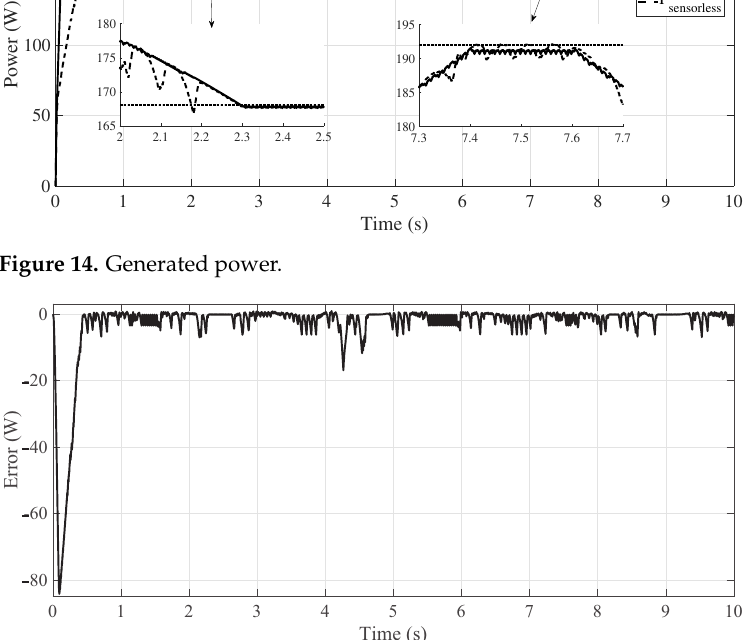
Figure 15. Power error between measured and sensorless based INC